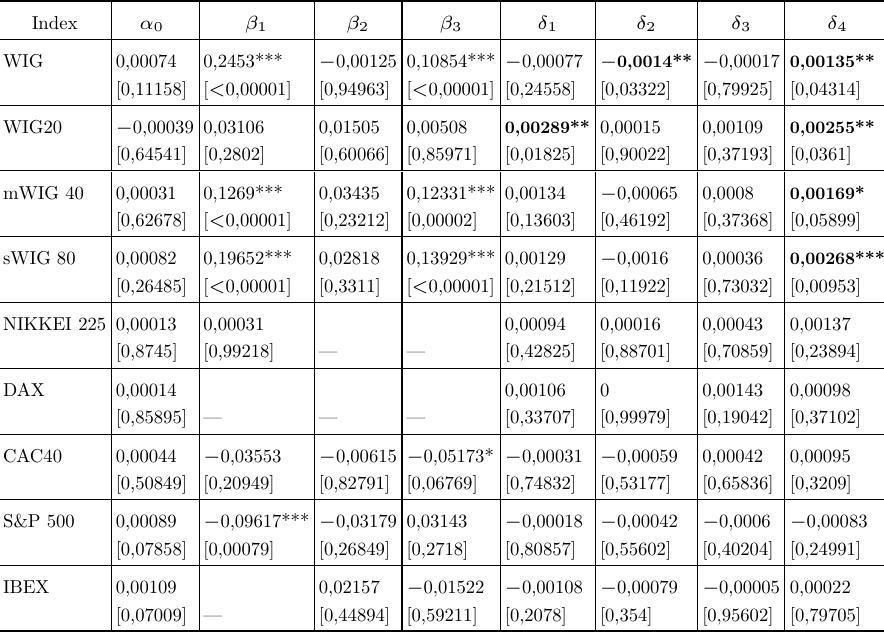
Results for the period: January 2003 – October